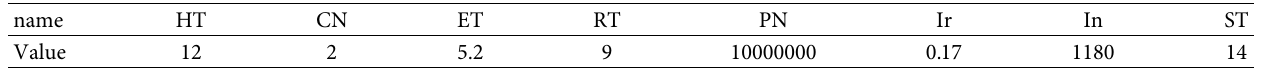
Table 4: Model parameter